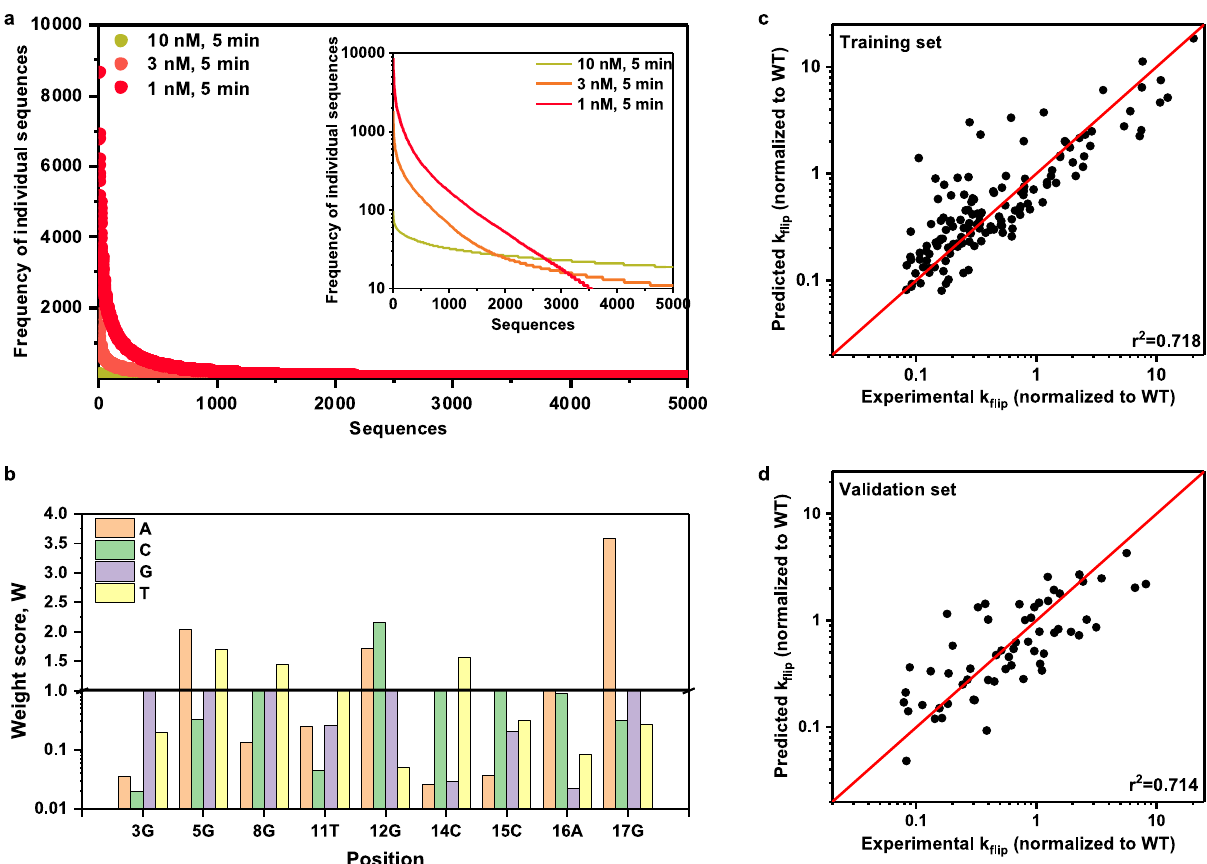
Fig. 3 Model fi tting of NGS data. a Occurrence frequency of individual sequences from library 2 selected with different Bxb1 concentrations. b Weight scores generated from linear regression. Experimental log(k fl ip ) values are derived from the occurrence frequency in NGS results (Supplementary Method 2). Weight scores of the reference WT sequences are fi xed as 1 (i.e., W i1 = 1). For the y -axis in 3b, 0.01-1 is on a log 10 scale and 1 – 4 is on a linear scale. c Predicted k fl ip values from the model correlate with the experimental k fl ip values for 140 randomly chosen training sequences (70% of 200 randomly chosen sequences from the top 3000 hits in a selection with 1nM Bxb1). d Predicted k fl ip values from the model correlate with the experimental k fl ip values for 60 randomly chosen validation sequences (the remaining 30% of these 200 randomly chosen sequences). Source data are provided as a Source Data fi